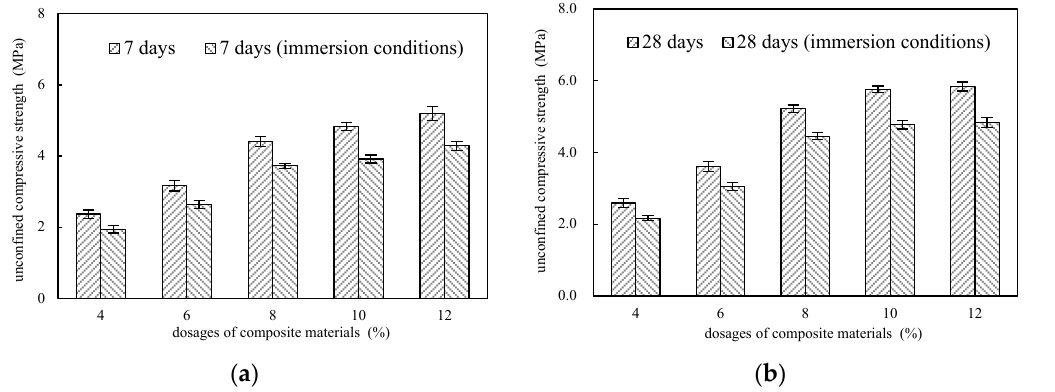
Figure 5. Unconfined compressive strength of solidified red mud after immersion in water. ( a ) is strength comparison of 7 days, ( b ) is strength comparison of 28 days.